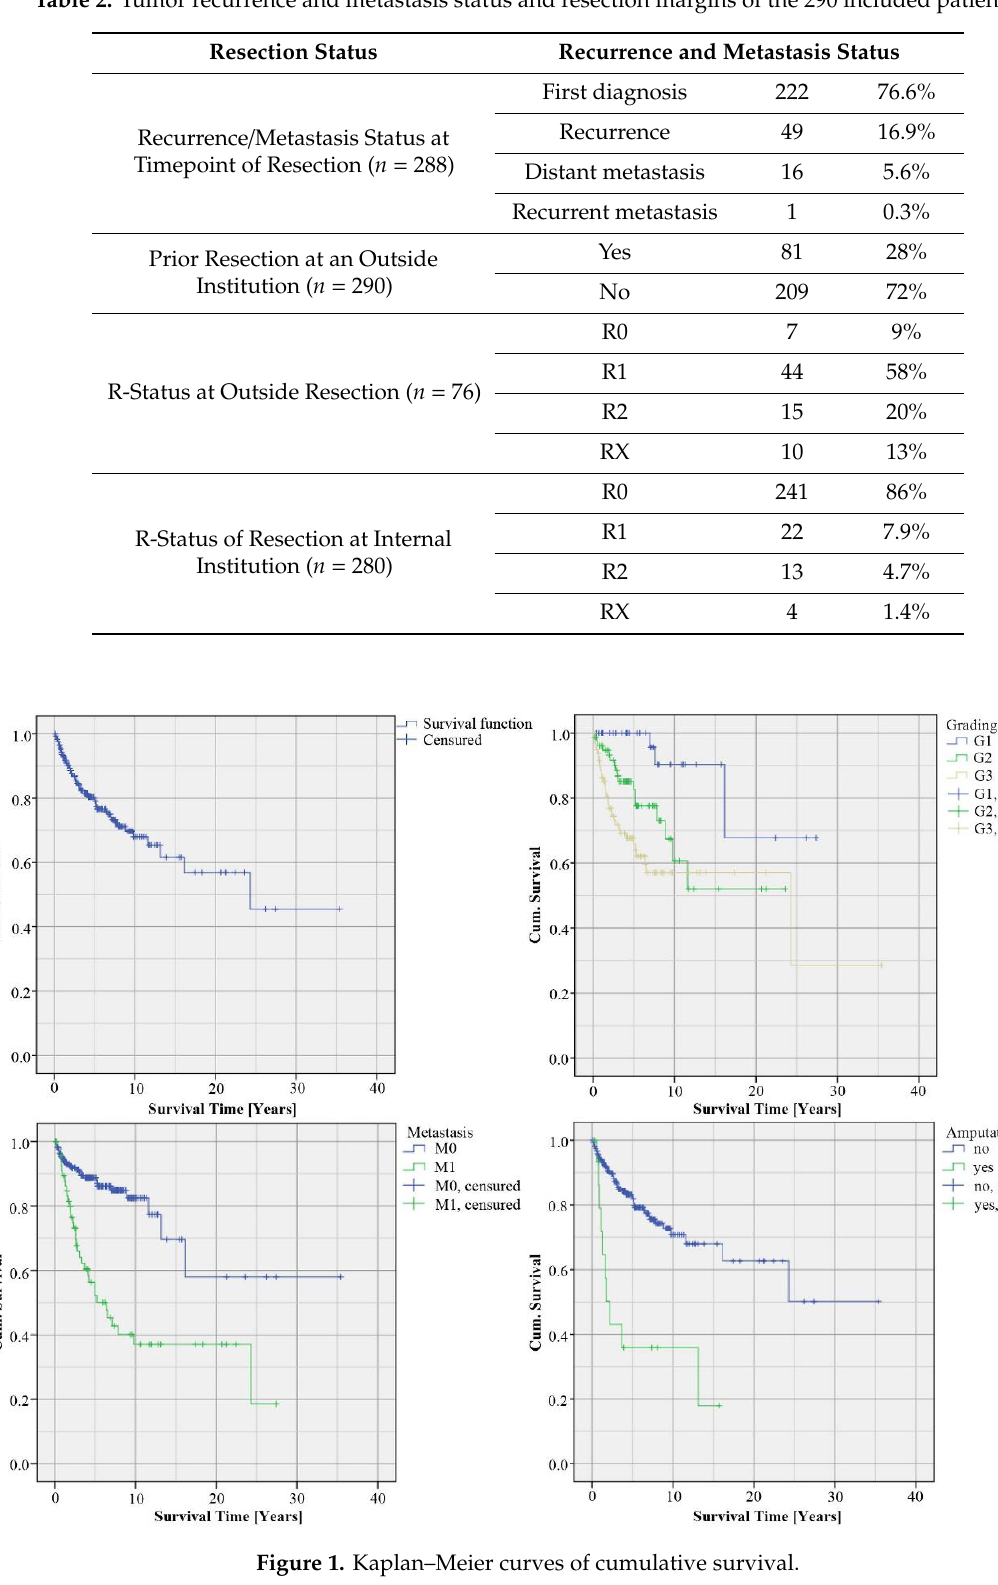
Table 2. Tumor recurrence and metastasis status and resection margins of the 290 included patients.